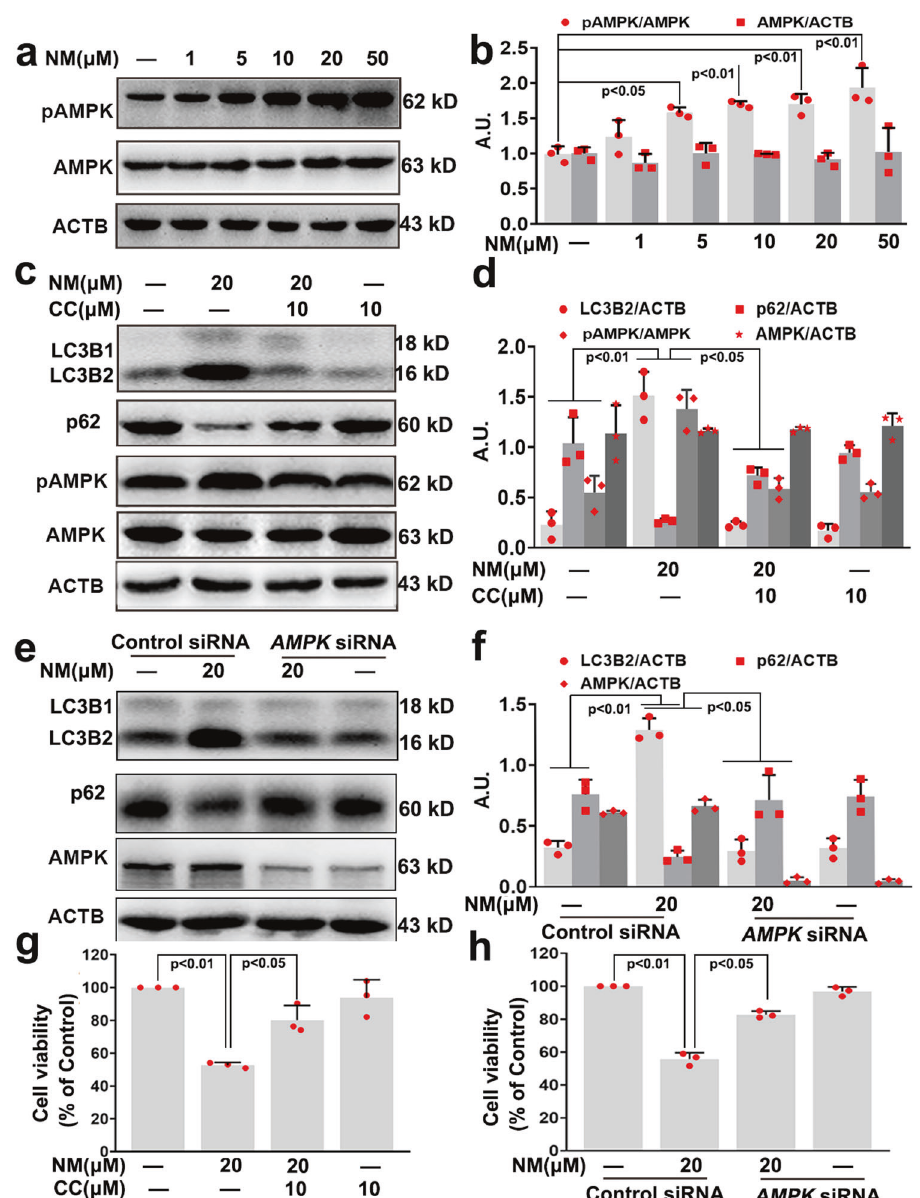
endogenous pAMPK. c Cells were pretreated with CC (10 µM) for 1 h followed by exposure to NM (20 µM) for an additional 24 h. Cells were collected and lysed, and then western blot analysis was performed. d The bar graph shows the quanti fi cation of the indicated proteins. e AMPK was knocked down by AMPK siRNA as described in “ Materials and methods ” . At 24-h post-transfection, the cells were treated with NM (20 µM) for 24 h. Cells were collected and lysed, then western blot analysis was performed. f The bar graphs show the quanti fi cation of the indicated proteins. g Cells were treated as described in ( c ), and cell viability was detected by a CCK-8 detection kit. h Cells were treated as described in ( e ), and cell viability was detected by a CCK-8 detection kit. Values are expressed as the means ± SD ( n = 3); A.U. arbitrary